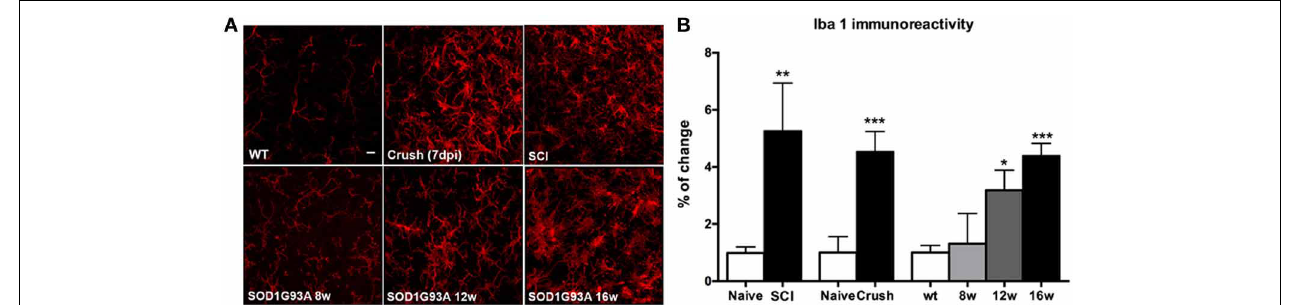
FIGURE 6 | Comparison of microglial (Iba-1 labeled) immunoreactivity in SOD1 G93A , SCI and sciatic nerve injured mice. (A) Representative confocal images of the ventral part of the lumbar spinal cord of wild type/naïve, SOD1 G93A at 8, 12, and 16 weeks of age, SCI and sciatic nerve crush injured animals. Scale bar 10 µ m. (B) Iba-1 immunoreactivity